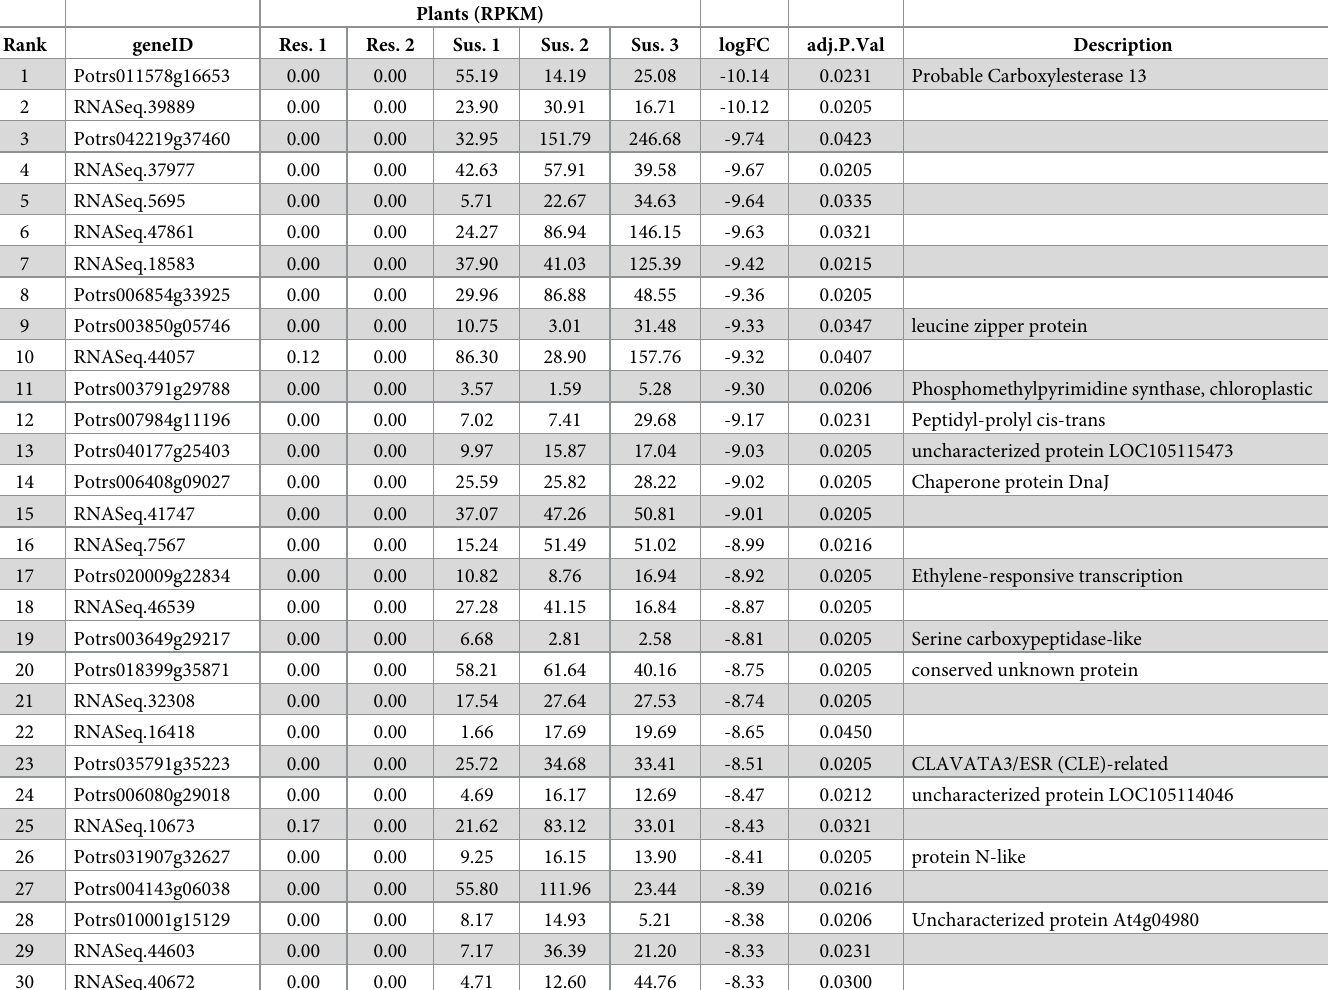
Table 3. Top 30 downregulated transcripts in resistant trembling aspen ( Populus tremuloides ) genotypes compared to susceptible trembling aspen genotypes based on